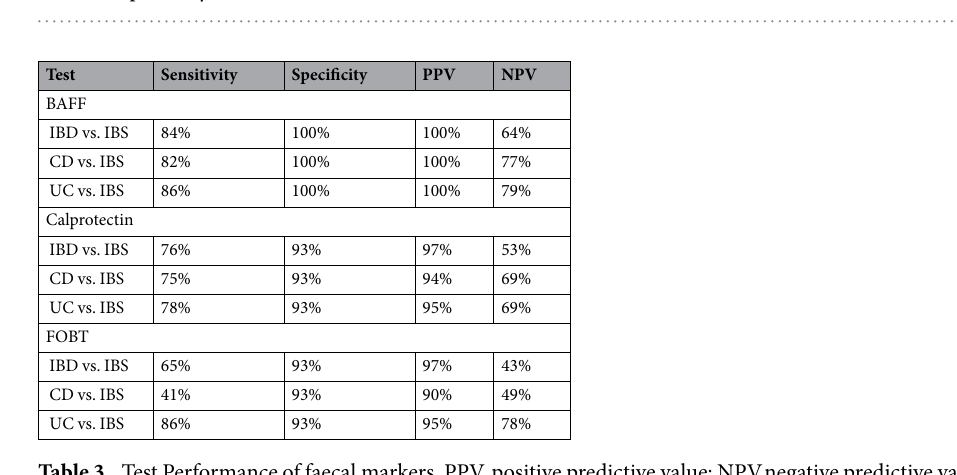
Figure 1. Receiver operating characteristic (ROC) curve of faecal BAFF, calprotectin, FOBT, and combined faecal calprotectin with BAFF in discriminating IBD from IBS with the area under the curve (AUC) of 0.928 (95% CI 0.884–0.973), 0.918 (95% CI 0.860–0.976), 0.786 (95% CI 0.698–0.873) and 0.947 (95% CI 0.903– 0.991),